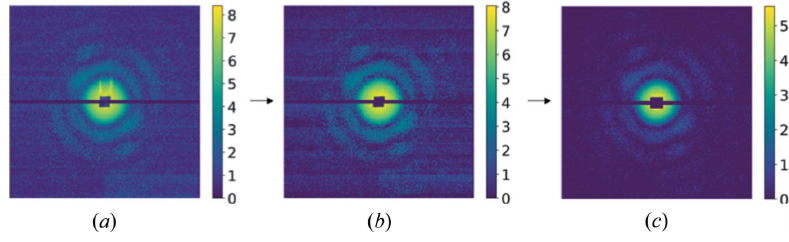
Figure 1 Pre-treatment of scattering patterns. ( a ) The original pattern, ( b ) after ‘bad’-pixel fixation using Friedel symmetry and ( c ) after photon-count conversion. The intensities are shown in logarithm scale to display the details. The apparent contrast difference between ( b ) and ( c ) is caused by the removal of weak signals (negative or analogue signals smaller than one photon were set to